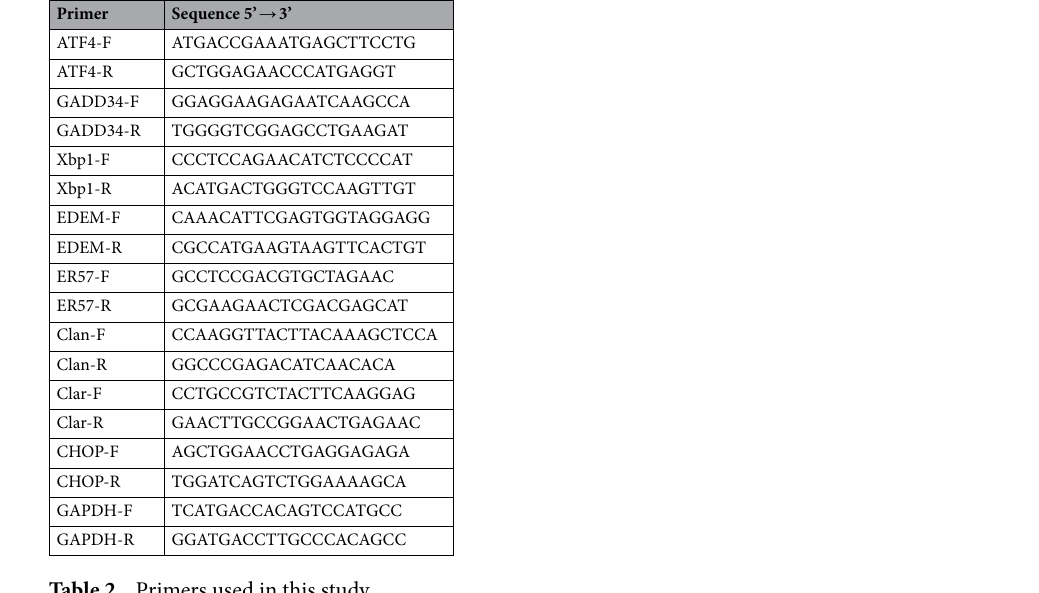
Table 2. Primers used in this